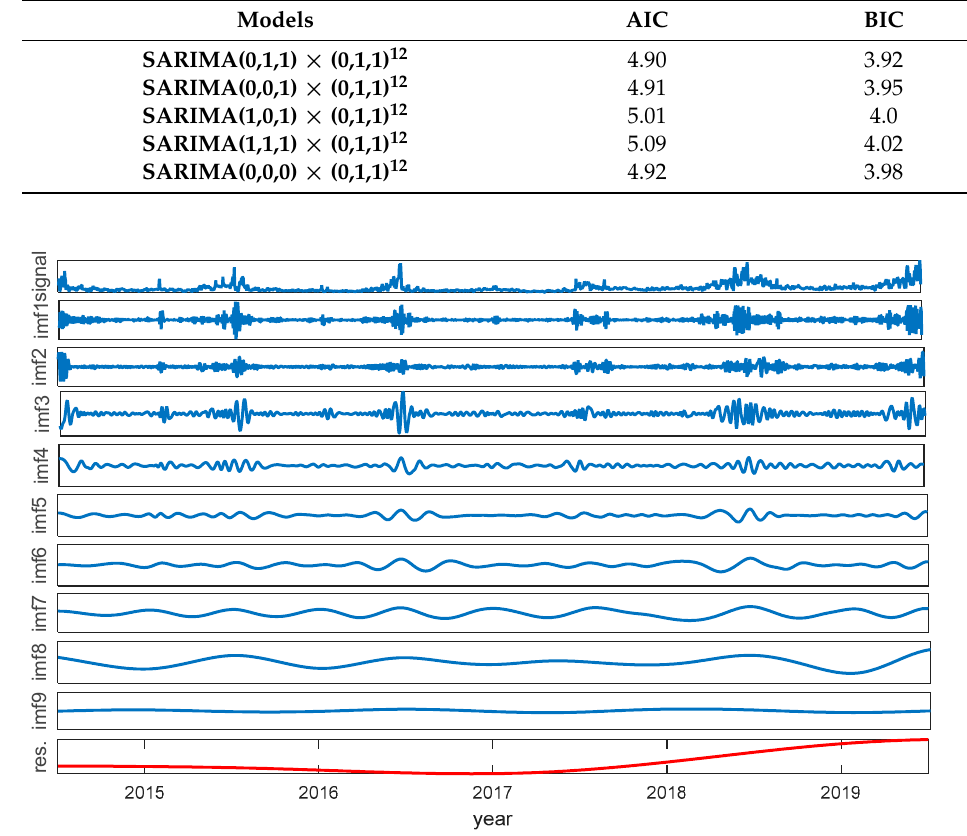
Figure 7. IMFs and residual of the AQI time series from 2015 to 2019.